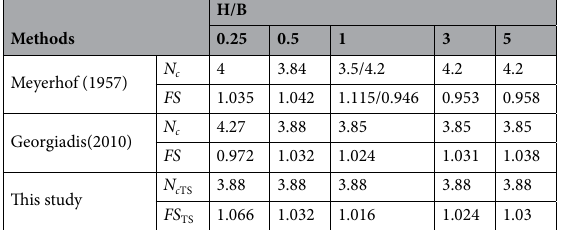
Table 2. Comparison of N c and FS. Note: Symbol “/” represents N c and FS oscillating; TS represents This study.